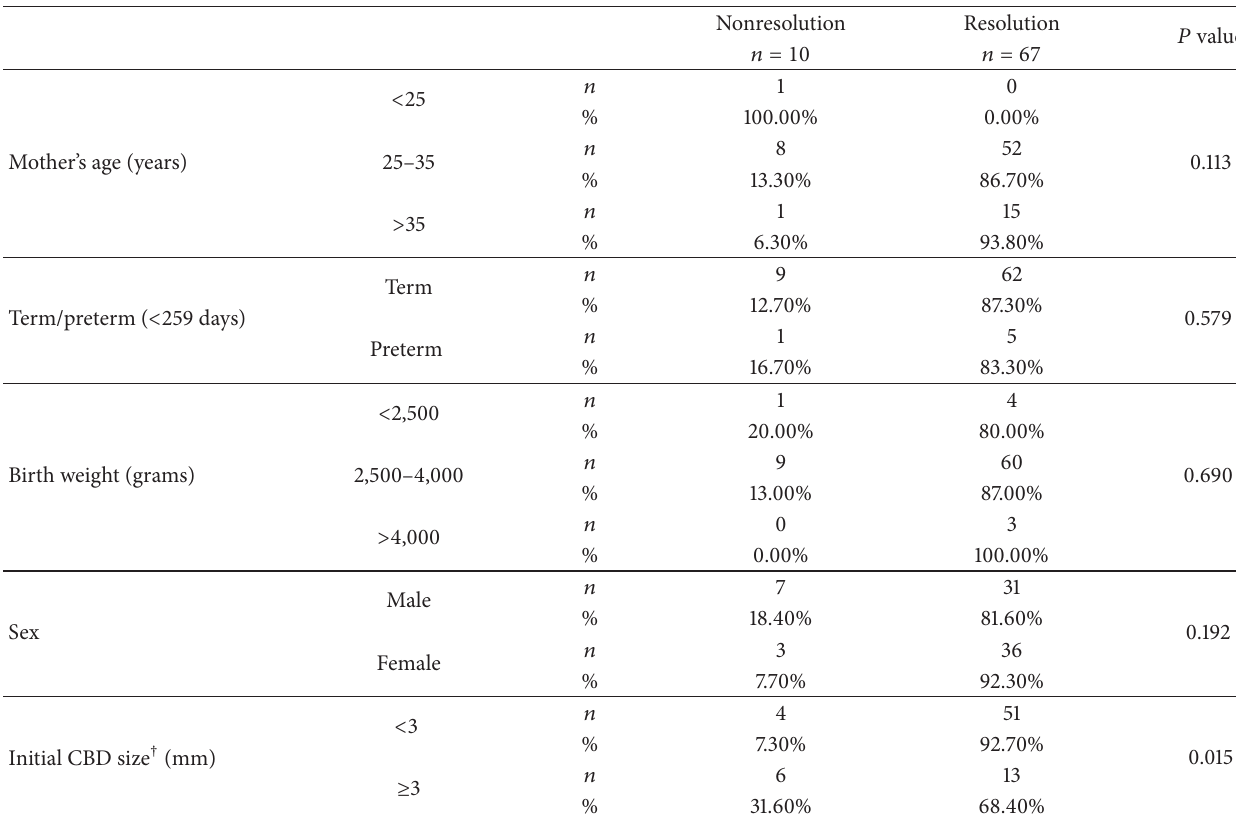
Table 2: Factors predicting resolution ∗